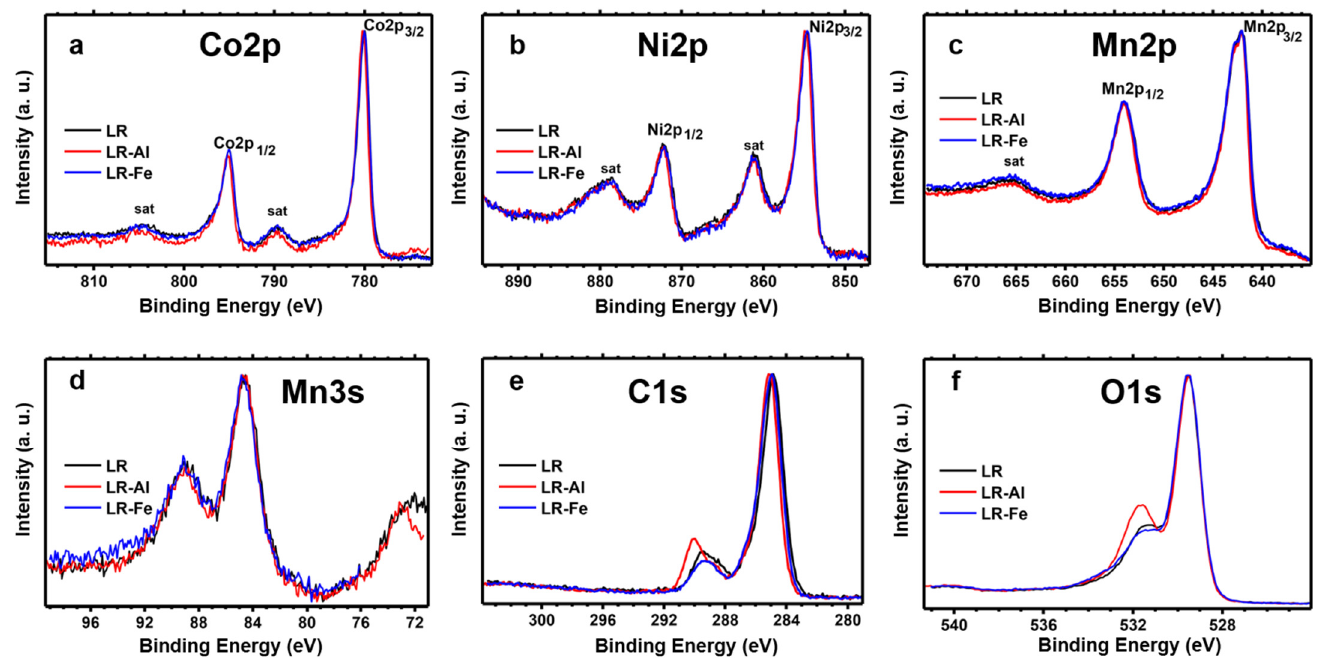
Figure 3. Normilized high-resolution ( a ) Co2p, ( b ) Ni2p, ( c ) Mn2p, ( d ) Mn3s, ( e ) C1s, and ( f ) O1s XPS spectra of LR, LR-Al and LR-Fe.